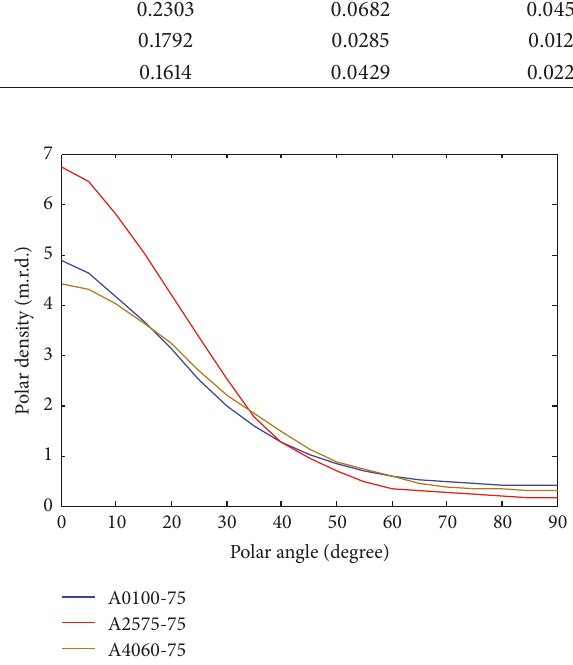
Figure 4: Experimental 𝑐 -axis distribution density figures of the kaolinite in the 3 samples with corresponding integrated polar angle profiles. Distribution density is expressed in multiples of random distribution